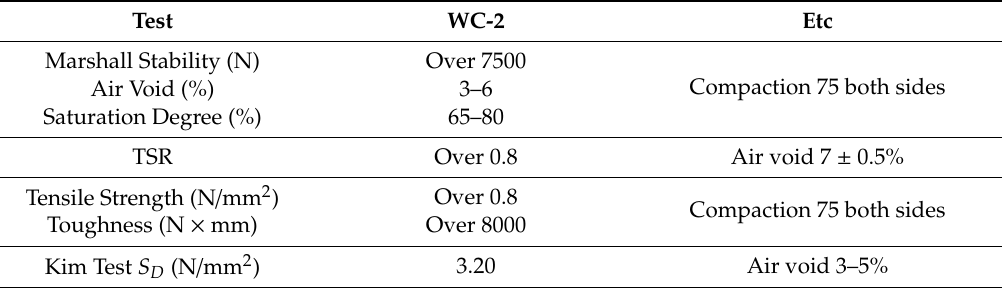
Table 4. Korean Asphalt standard for